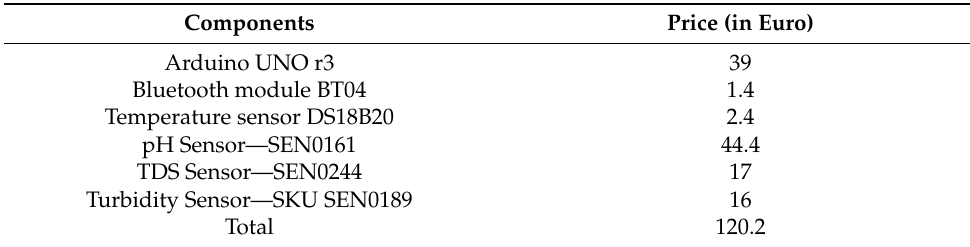
Figure 4. Setup of the Arduino-based sensor system. Table 2. Components prices for a low-cost system approach. Components